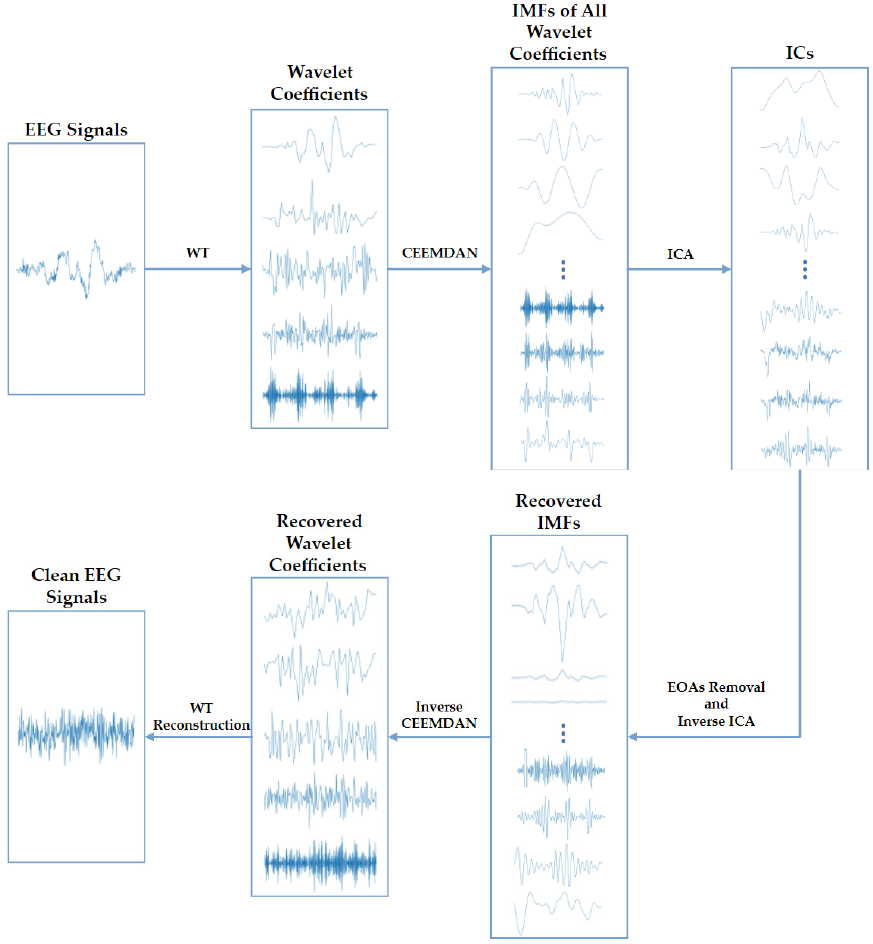
Figure 2. The algorithm flowchart of the WT-CEEMDAN-ICA method used to remove EOAs from EEG signals.